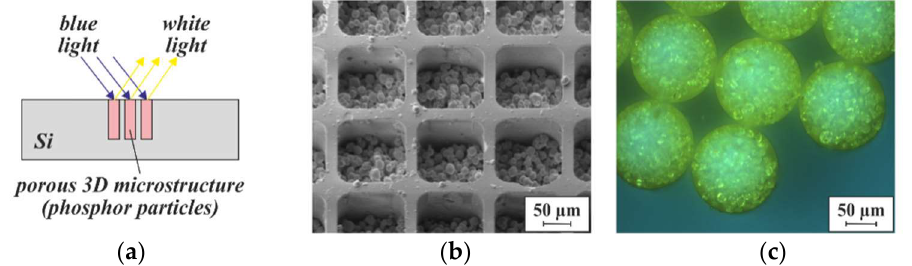
Figure 15. ( a ) Schematic illustration of a PowderMEMS luminescence converter based on agglom- erated phosphor particles [32]. ( b ) SEM micrograph of the top side of a converter array, consisting of square-shaped pixels. ( c ) Optical image of the bottom side of another converter array, consisting of circular pixels, after removal of the Si substrate by etching in XeF 2 vapor. A close-up of a phos- phor-based microstructure can be found in Figure 10f.